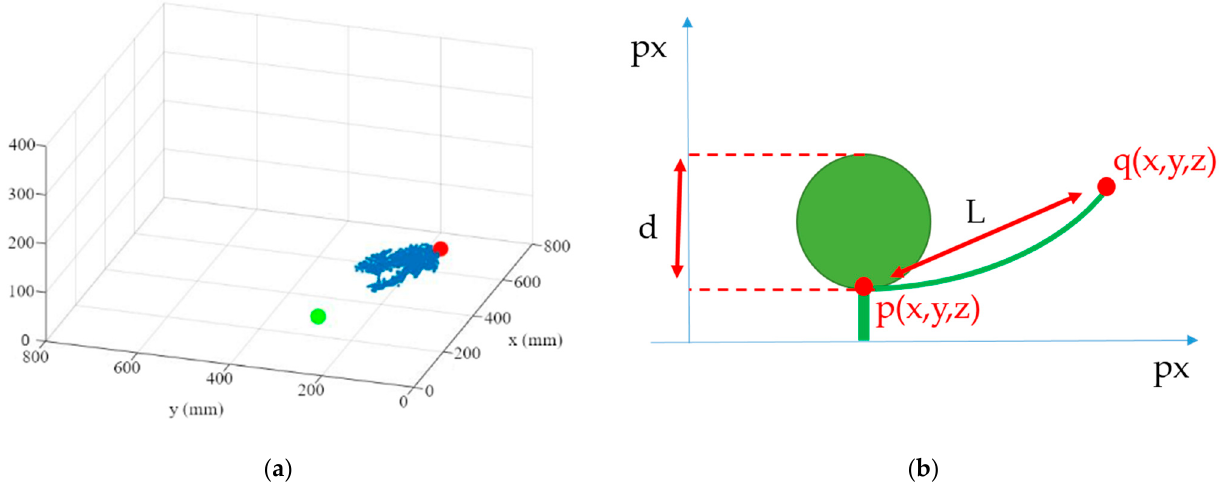
Figure 10. ( a ) Point cloud of the leaf with cabbage center green and leaf endpoint red; ( b ) sketch of the side-view of the cabbage head and leaf with measuring points noted.